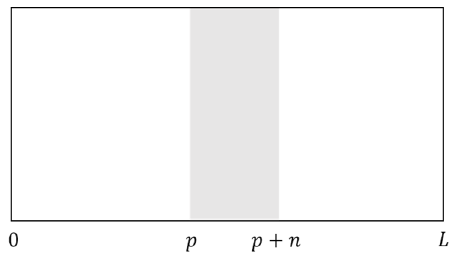
Figure 4. Proposed method applied to base input spectrogram. The section to which the proposed method was applied is shown in gray.